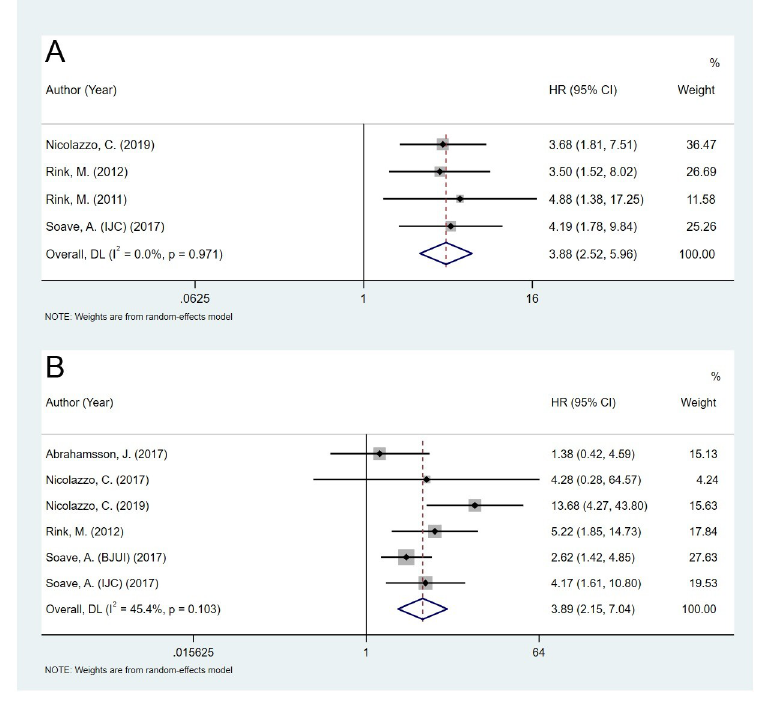
was observed between the studies (I 2 = 0.0%, p = 0.971). Six studies that included 654 patients